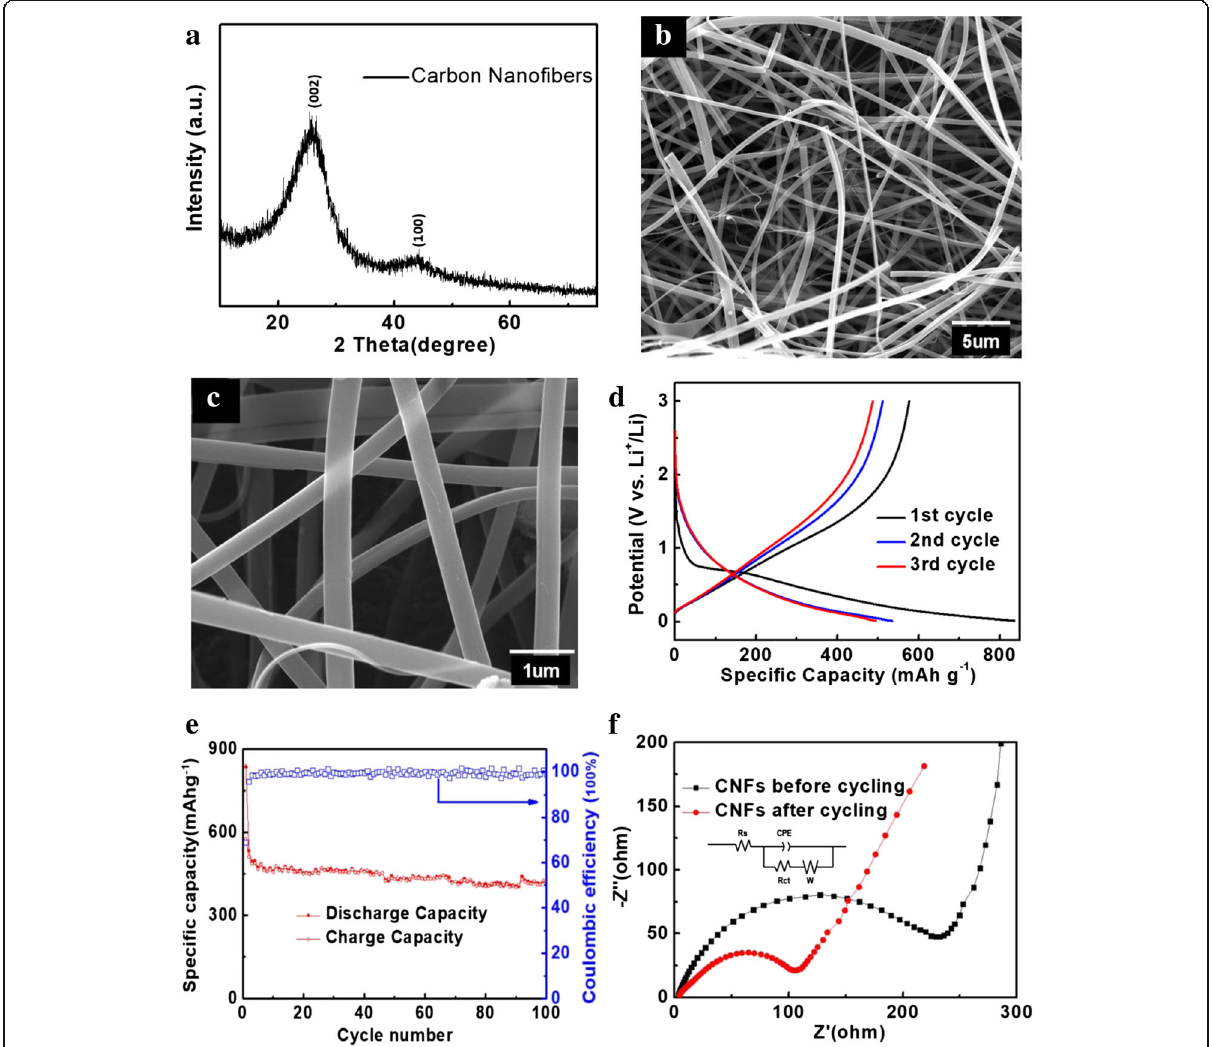
Fig. 4 a XRD pattern, b , c SEM images, d charge – discharge curves, and e cycling performance of CNFs anode and f Nyquist plots at the OCP and the equivalent circuit for electrospun CNF electrodes before and after discharge/charge